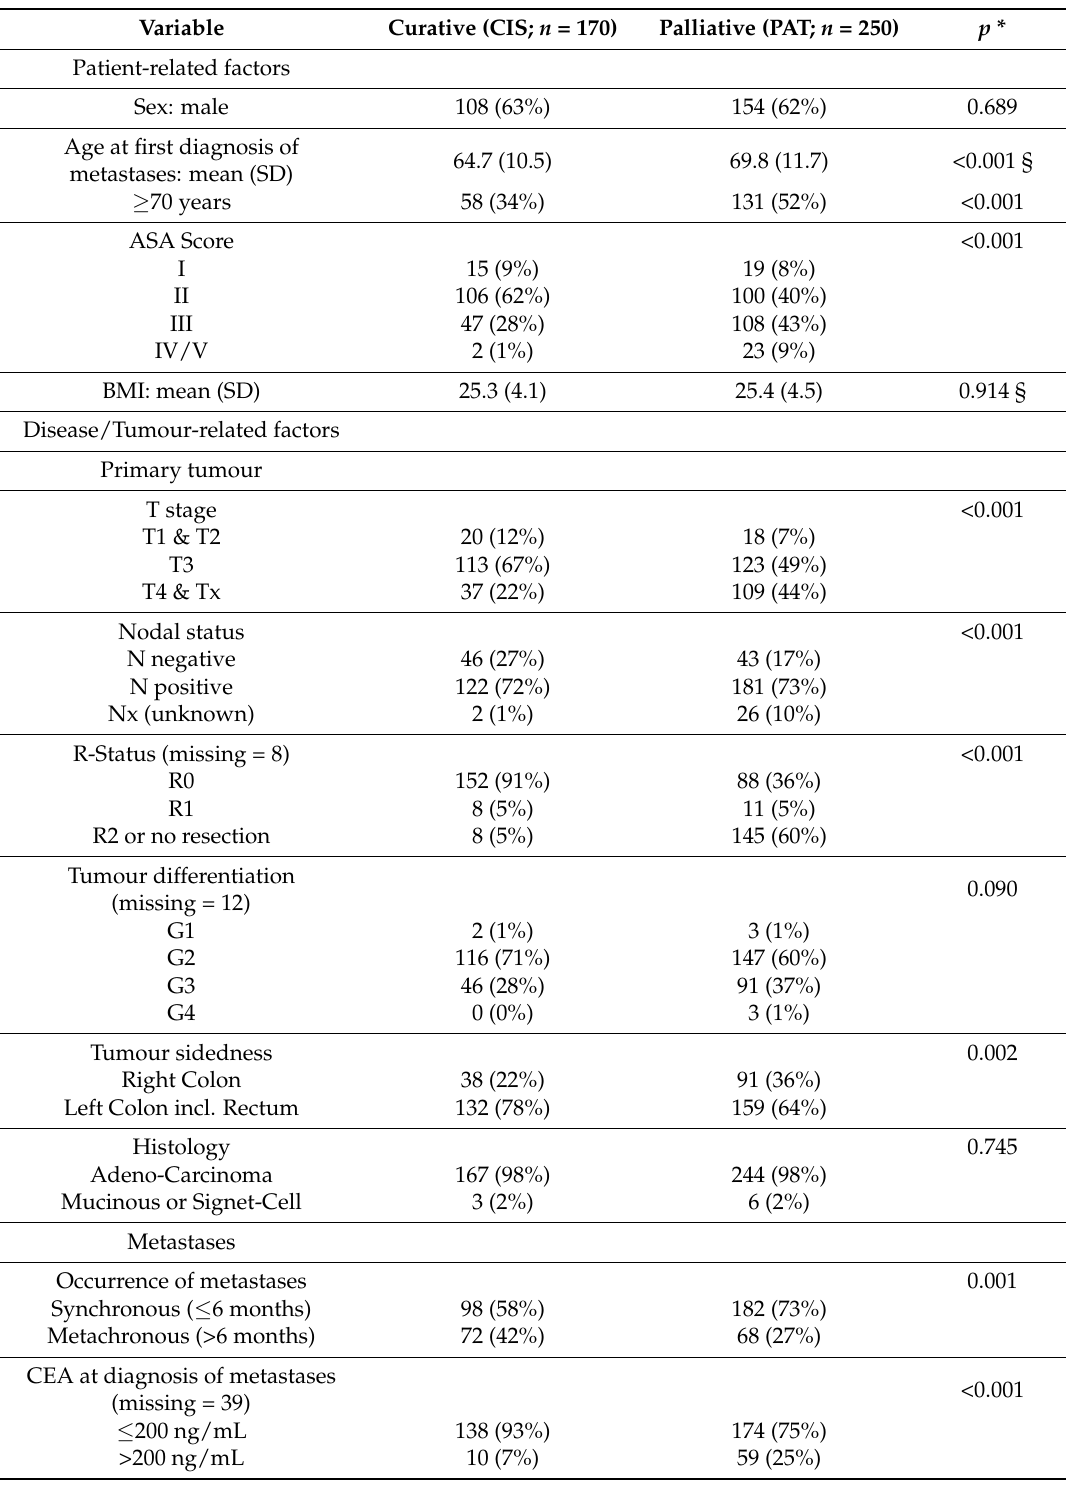
Table 2. Differences in the characteristics of curative (CIS) and palliative (PAT)